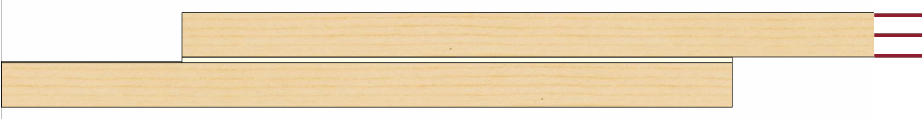
Figure 25. Illustration of the boundary conditions applied.